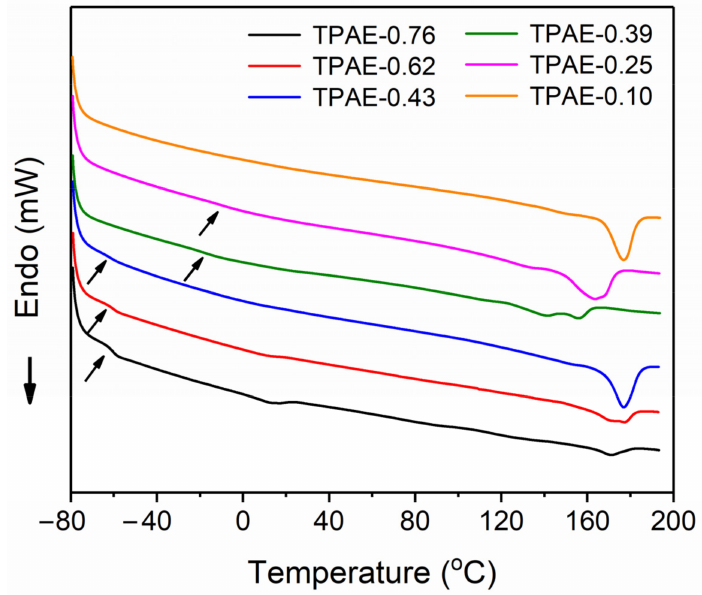
Figure 4. DSC thermograms of different